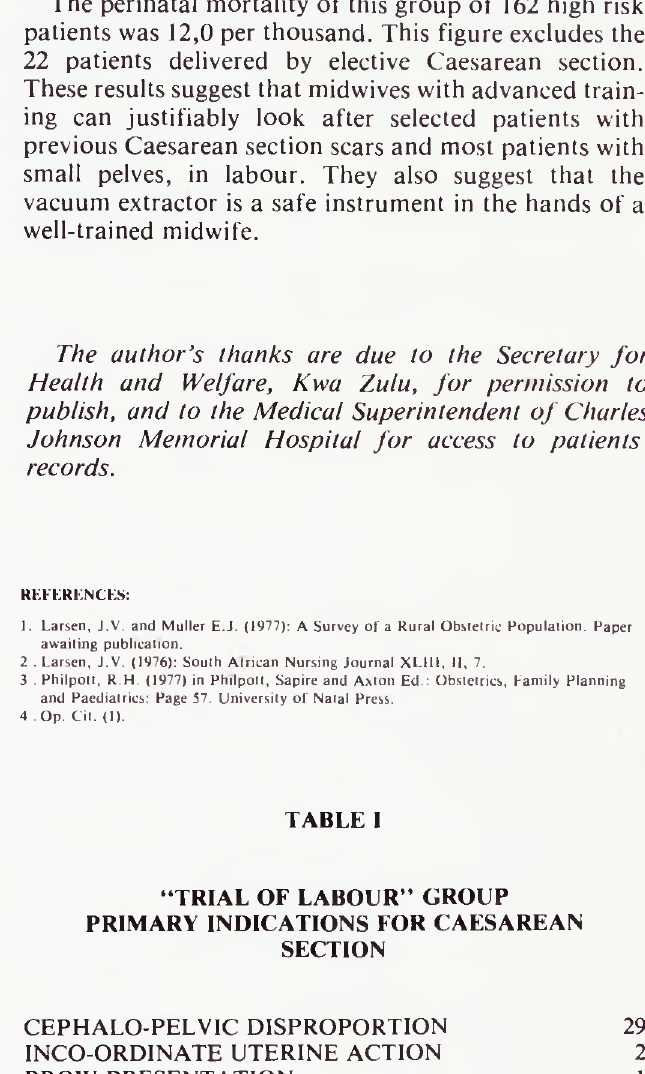
“TRIAL OF LABOUR” GROUP PRIMARY INDICATIONS FOR CAESAREAN